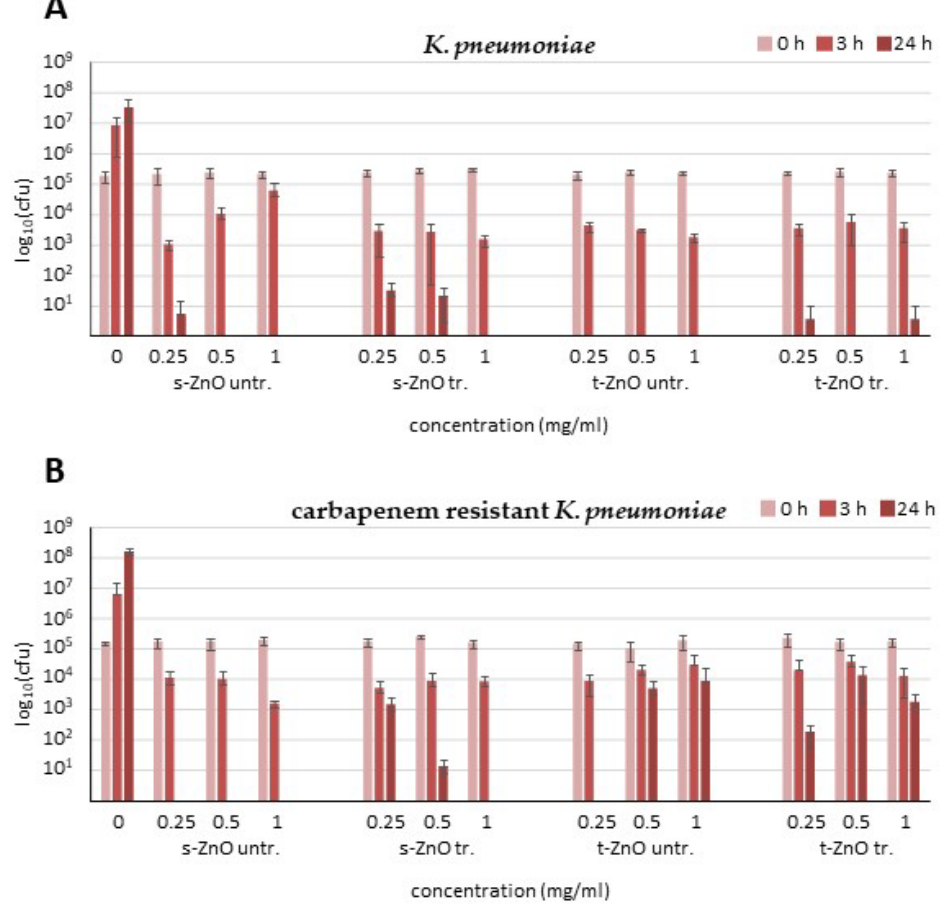
Figure 4. Antibacterial efficacy testing of untreated s-ZnO particles (s-ZnO untr.), methylene blue- treated particles (s-ZnO tr.), untreated ZnO tetrapods (t-ZnO untr.), and methylene blue-treated ZnO tetrapods (t-ZnO tr.) against ( A ) carbapenem-sensitive K. pneumoniae and ( B ) carbapenem-resistant K. pneumoniae . Data are presented as mean values from three independent experiments ( n = 3) with standard deviations. Drug concentrations are shown in mg/mL. cfu = colony forming units.